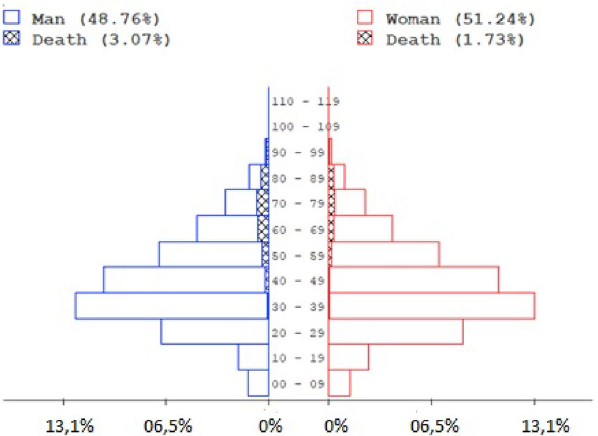
Figure 2. Distribution by sex, age, and clinical outcome of cases of SARS-CoV-2 infection in the State of Pará- Amazon-Brazil, 2020. Source: OpenDataSUS, Ministry of Health.